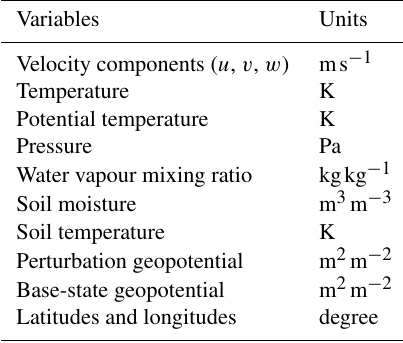
Table 2. Variables used in